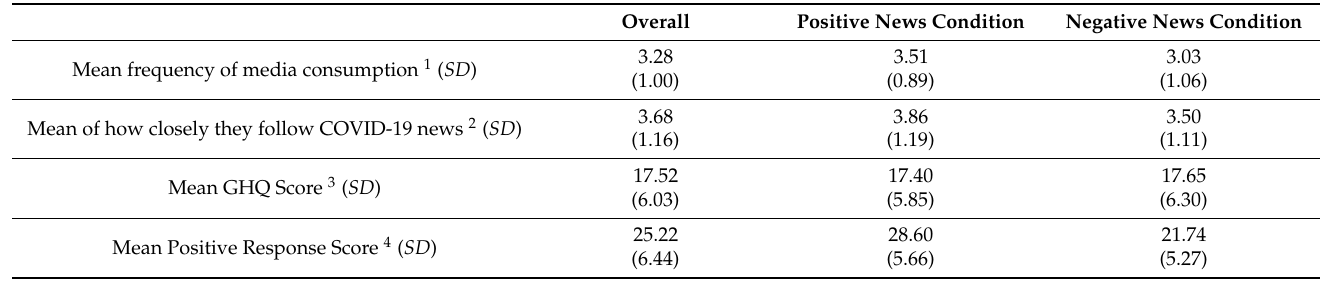
Table A2. Means and SD of Variables of Interest, Overall and by